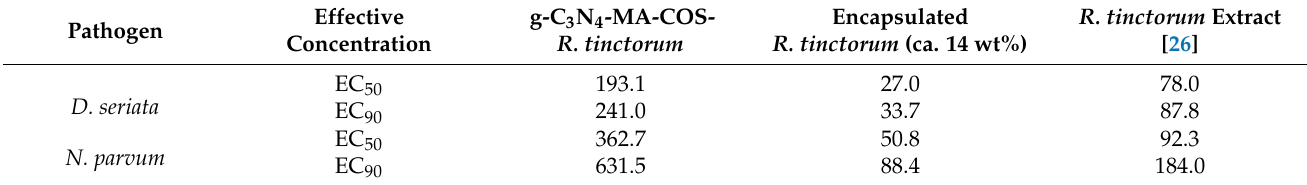
Table 4. Comparison between the effective concentrations (EC 50 and EC 90 , in µ g · mL − 1 ) against D. seriata and N. parvum of the g-C 3 N 4 -MA-COS nanocarriers loaded with R. tinctorum extract and those of the equivalent encapsulated and non-encapsulated R. tinctorum